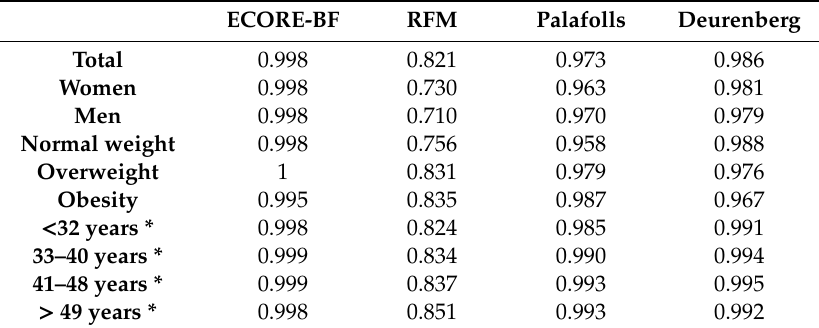
Table 3. Bivariate correlations between study formulas and